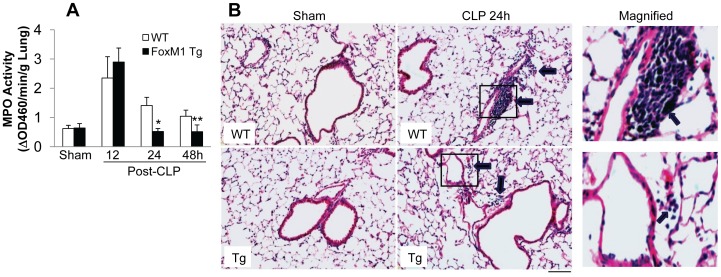
Accelerated resolution of lung inflammation in FoxM1 Tg mice.(A) MPO activities in lung tissues. Lung tissues at indicated times post-CLP challenge were collected for MPO activity determination. Lung tissues from sham-operated mice at 24 h post-surgery were collected as controls. Data are expressed as mean ± SD (n = 3–5). *, P<0.001 versus WT; **, P<0.05 versus WT. (B) Representative micrographs of H & E staining of lung sections. At 24 h post-surgery, lungs were fixed for sectioning and H & E staining. Arrows indicate perivascular leukocyte infiltration. Scale bar, 50 µm.